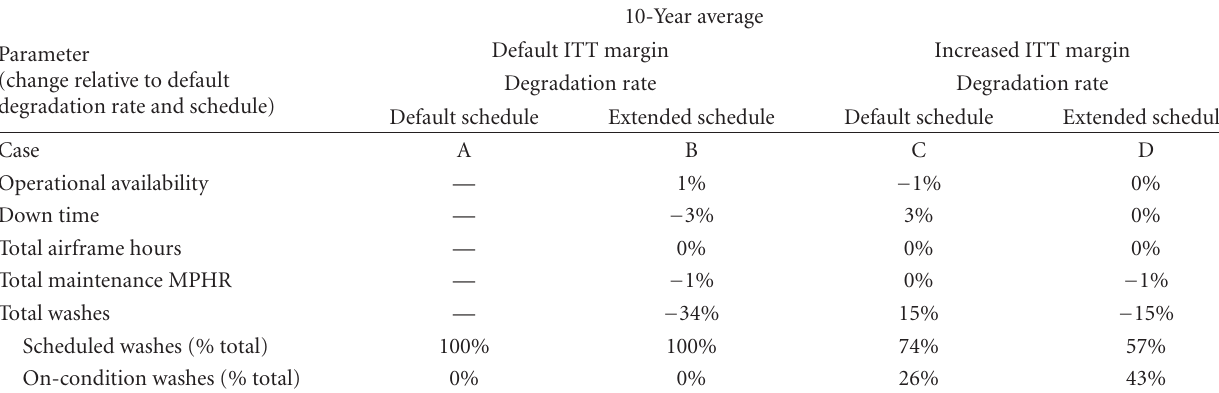
Figure 3: Aircraft flying hours and operational availability for variations in yearly flying rate. Table 1: Extension of engine wash interval